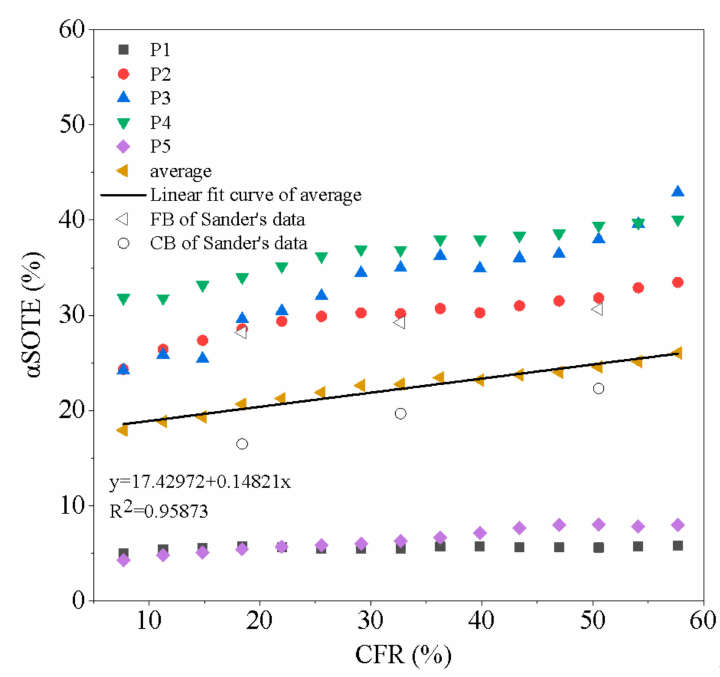
Figure 7. The α SOTE results under different